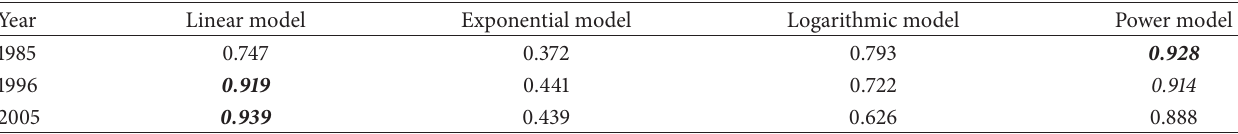
Table 5: Comparisons between the 𝑅 square values of four possible models for the area-perimeter relationships of the cities and towns in Yangtze River Delta, China